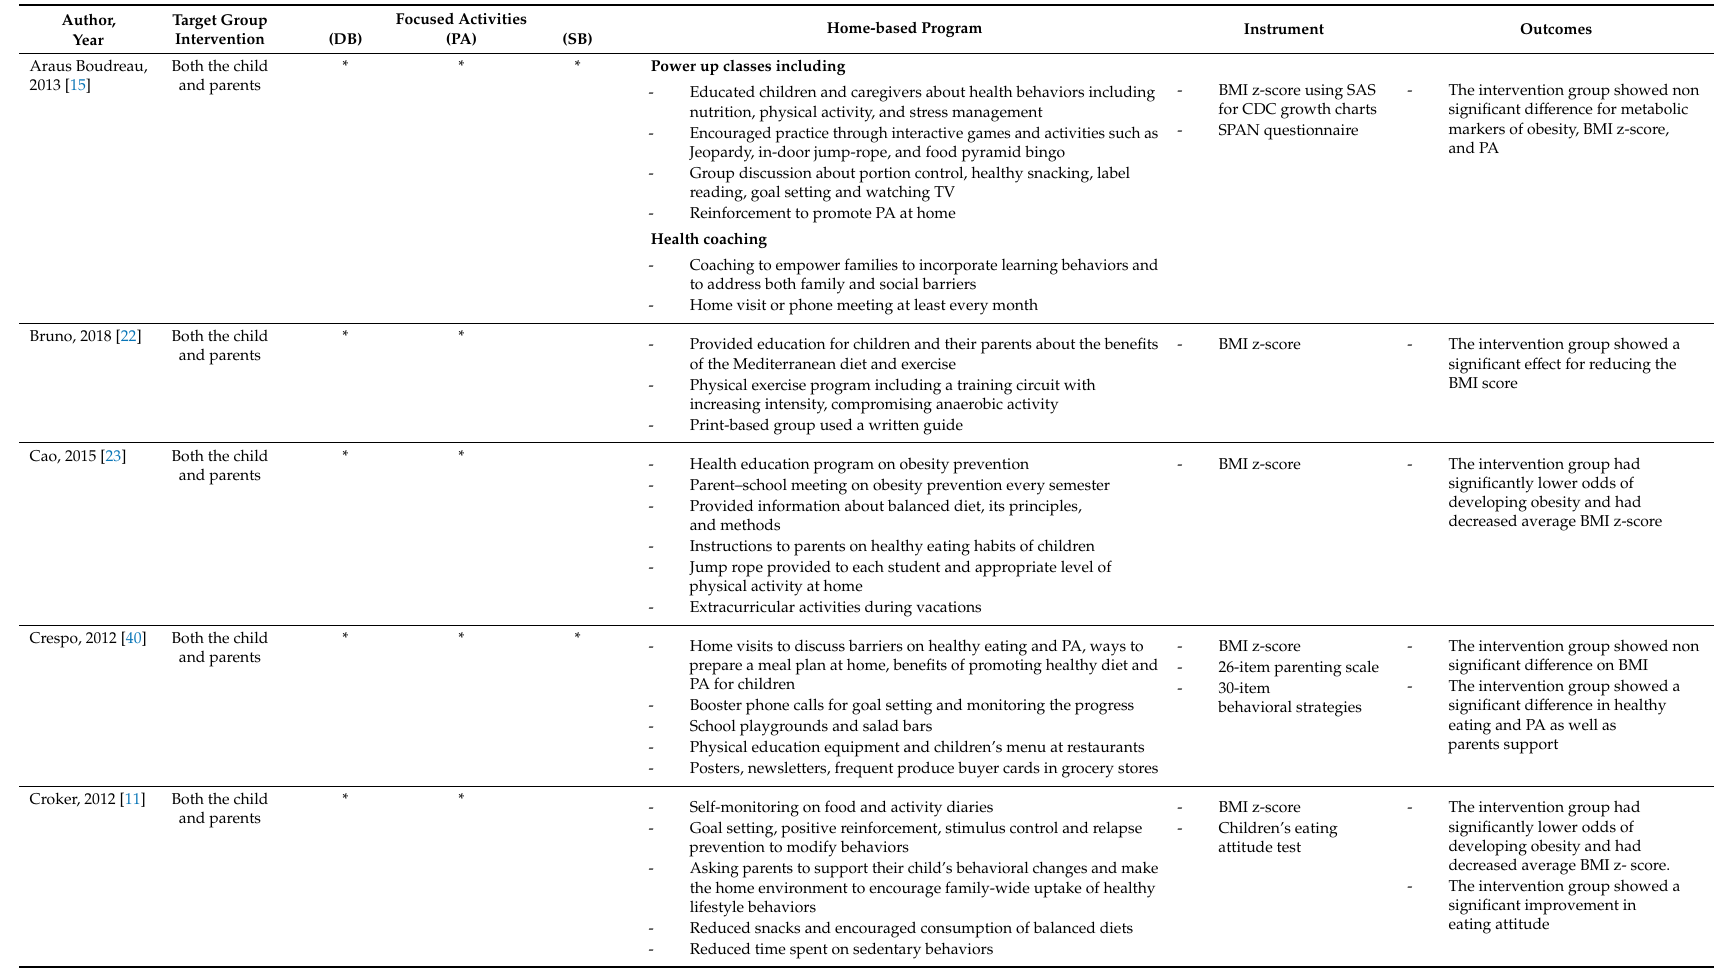
Table A1. Home-based intervention for childhood